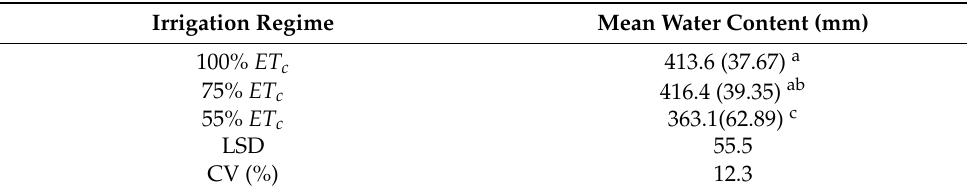
Table 6. Effects of irrigation regime on the soil water content.